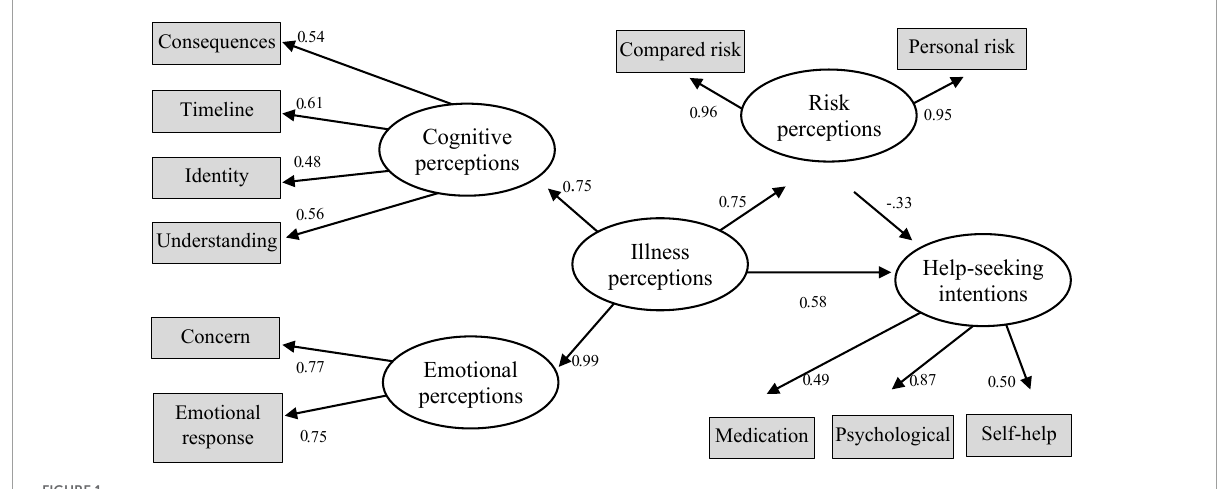
FIGURE1 Structural equation model (SEM) on the role of illness perception (IP) and risk perceptions in help-seeking intentions for